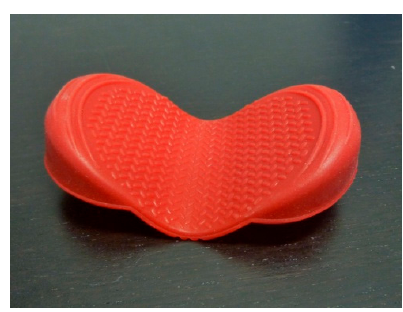
Figure A8. Pot holder.